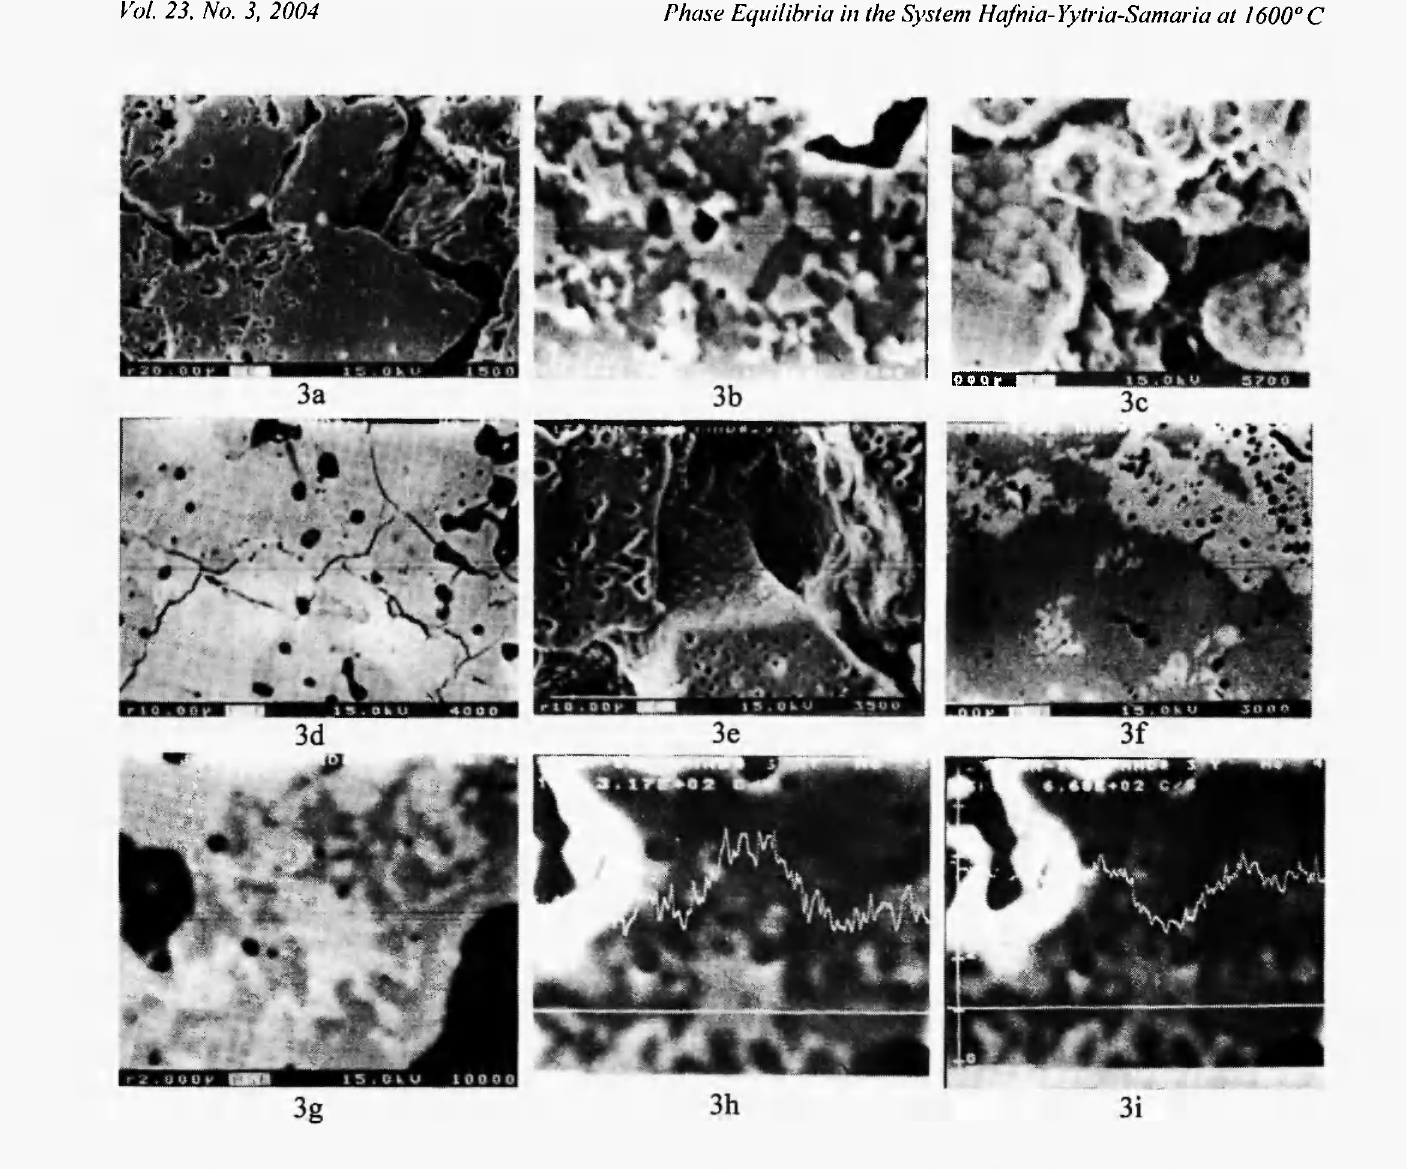
Fig. 3. Microstructures of the samples and element distribution through the samples in the definite field of compositions of the sub-system HfO 2 -Sm 2 Hf 2 0 7 -Y 2 0 3 heat-treated at 1600 °C: (a) Py, 57 mol% HfO 2 -10 mol% Y 2 0 3